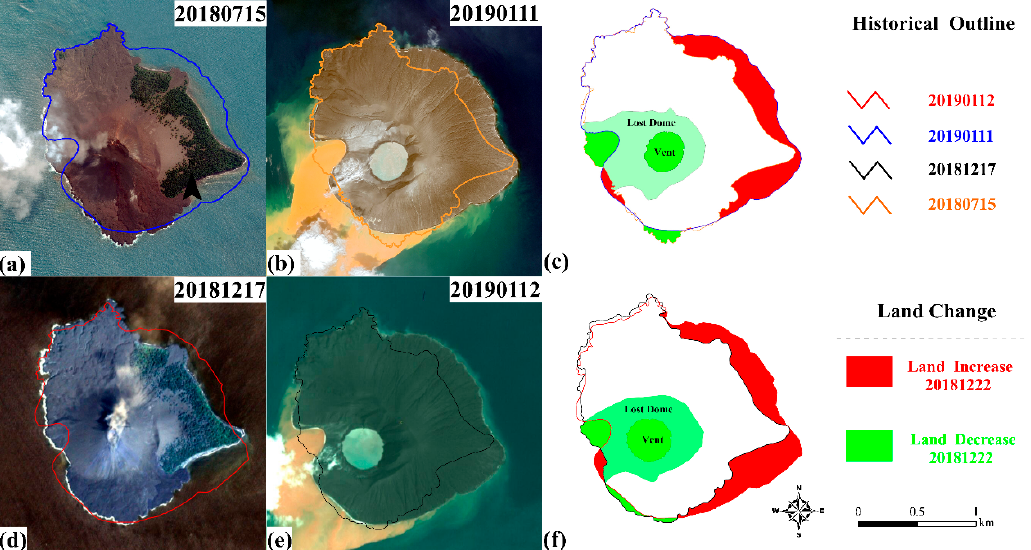
Figure 4. Comparative analysis of optical images: ( a ) the Google image on 15 July 2018; ( b ) the Google image on 11 January 2019; ( c ) morphological changes after eruptions (Google images); ( d ) the Planet image on 17 December 2018; ( e ) the Planet image on 12 January 2019; ( f ) morphological changes after eruptions (Planet images).